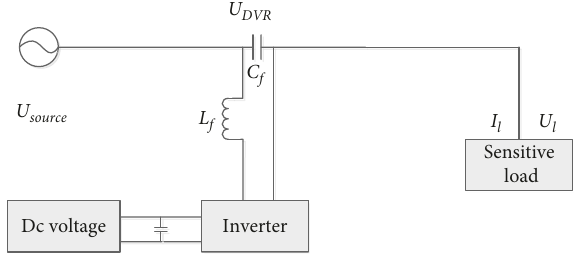
Figure 7: The circuit of DVR system connected to the grid.